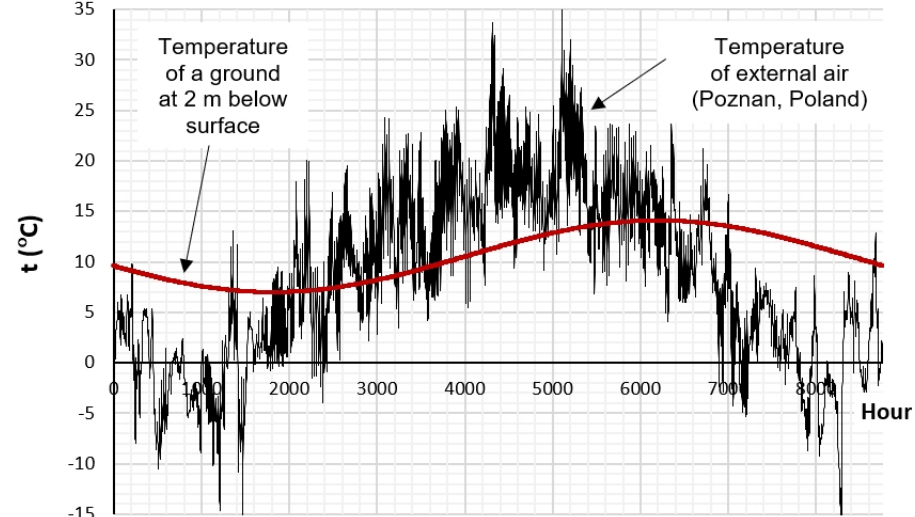
Figure 5. Ground temperature and external air temperature during the year taken into consideration in calculations, adopted from the authors’ previous work [43].